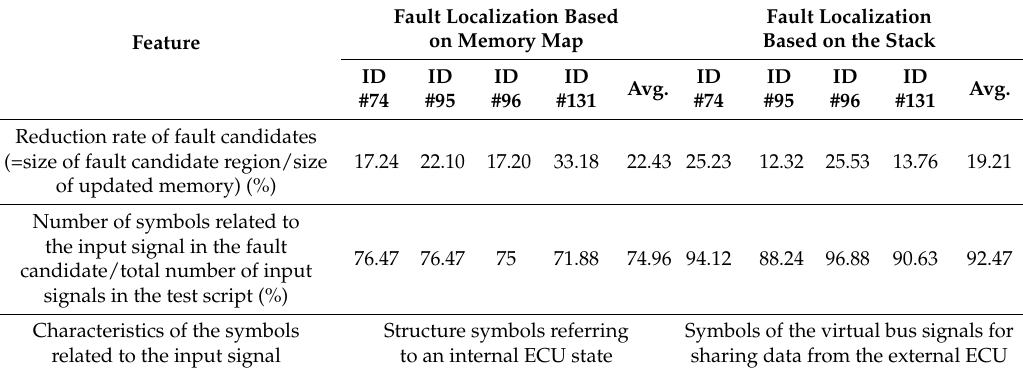
Table 5. Comparative results of the two fault-localization